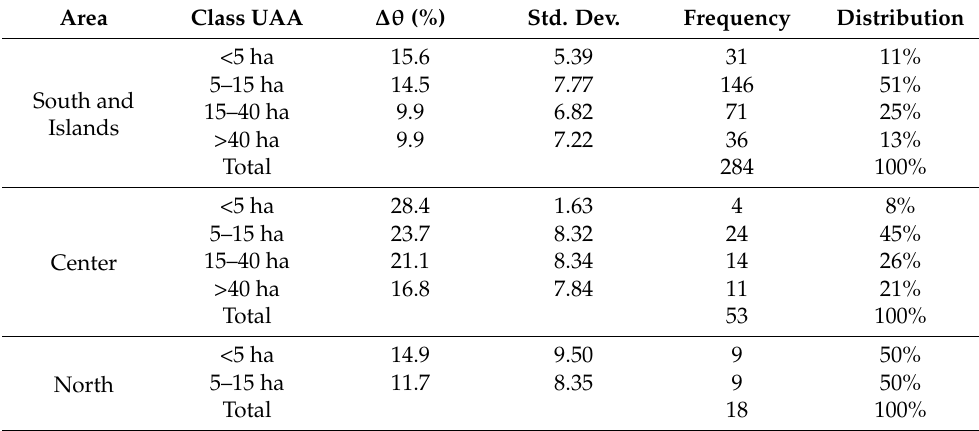
Table 5. Average percentage differences in TE for organic olive farms by macro areas and by UAA.